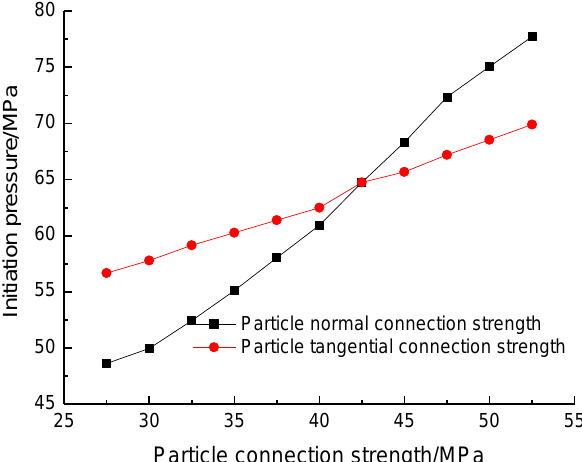
Figure 9. The relation between initiation pressure and particle connection strength.